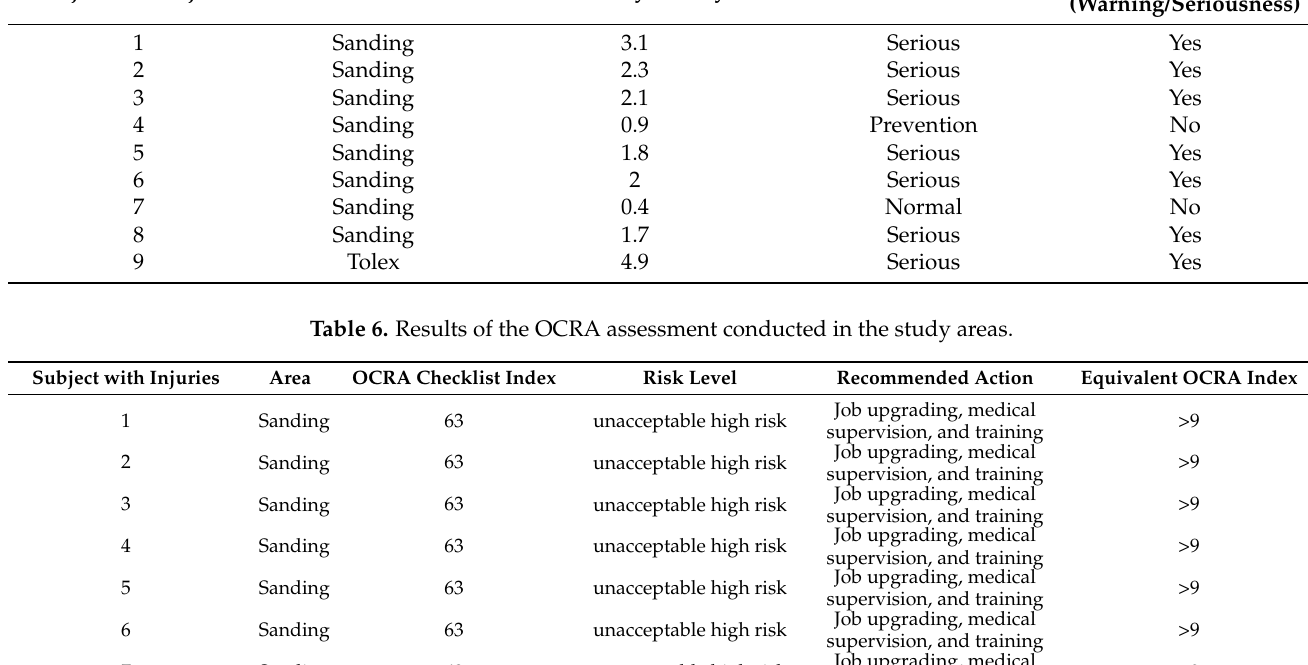
Figure 10. Graphs of minimum temperature differences between minT R (right wrist minimum temperature) and minT L (left wrist minimum temperature) points of subjects from the tolex area.